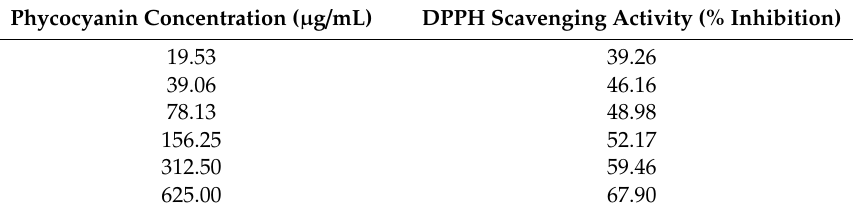
Table 1. Antioxidant activity of the phycocyanin.